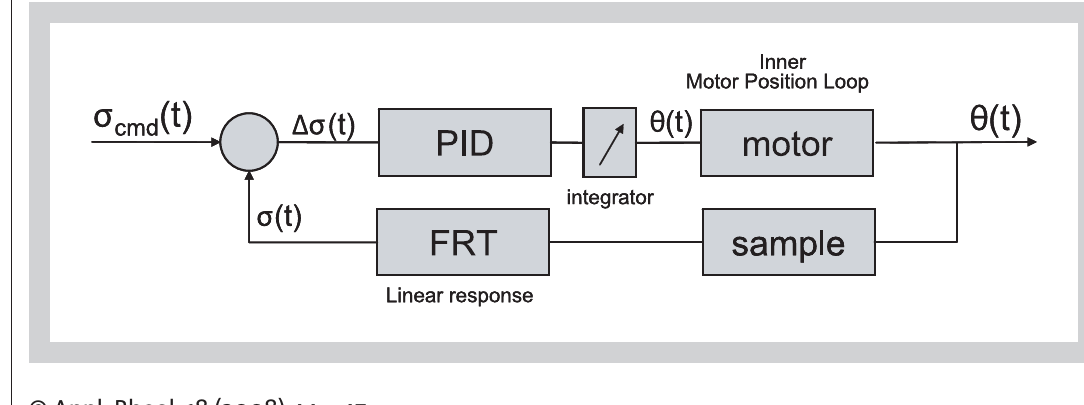
Figure 1: External control loop for stress controlled test with the